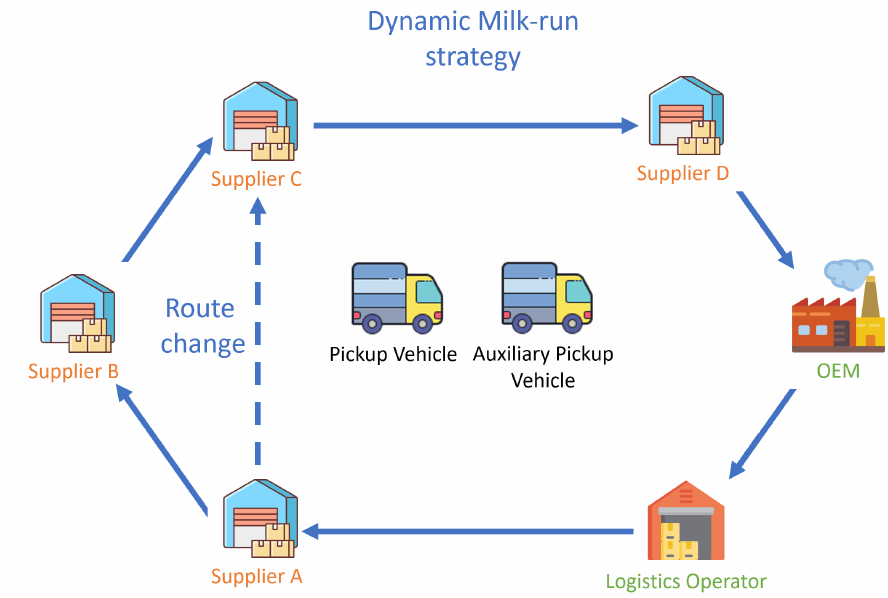
Figure 2. Dynamic Milk-run